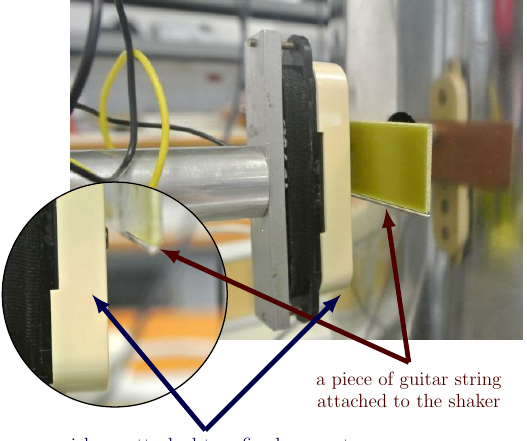
Figure 3. Measurement device used to characterize the nonlinearities of the pickup. A sample of a guitar string is glued on a non-magnetic rigid support, itself fixed to a shaker. An mu-metal shielding covers the shaker in order to limit its electromagnetic